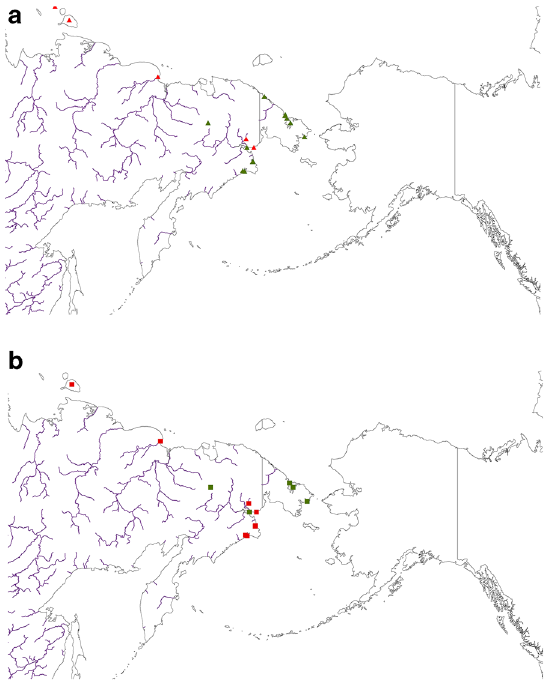
Figure 7. Best available occurrence data from the literature for ( a ) Tundra Bean Goose ( Anser fabalis; shown as triangles) and ( b ) Greater White-fronted Goose ( Anser albifrons; presented as squares. For both figures presence is shown in red and absence in green). Map created by FH with OpenSource QGIS and ArcGIS Desktop 10.6 academic license.